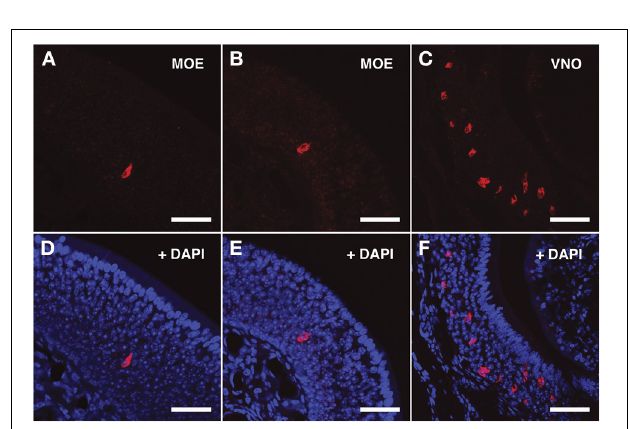
FIGURE 4 | In situ hybridization with Vmn2r26 riboprobes on serial sections of the MOE. (A,B) The Vmn2r26 antisense riboprobe hybridizes with a high number of cells throughout the MOE, mostly located in the basal and medial layers. (C) The Vmn2r26 antisense riboprobe specifically stains a high number of cells throughout the VNO. (D–F) Panels (A–C) merged with stained nuclei (DAPI). Scale bars: (A,B,D,E) 50 μ m; (C,F) 60 μ